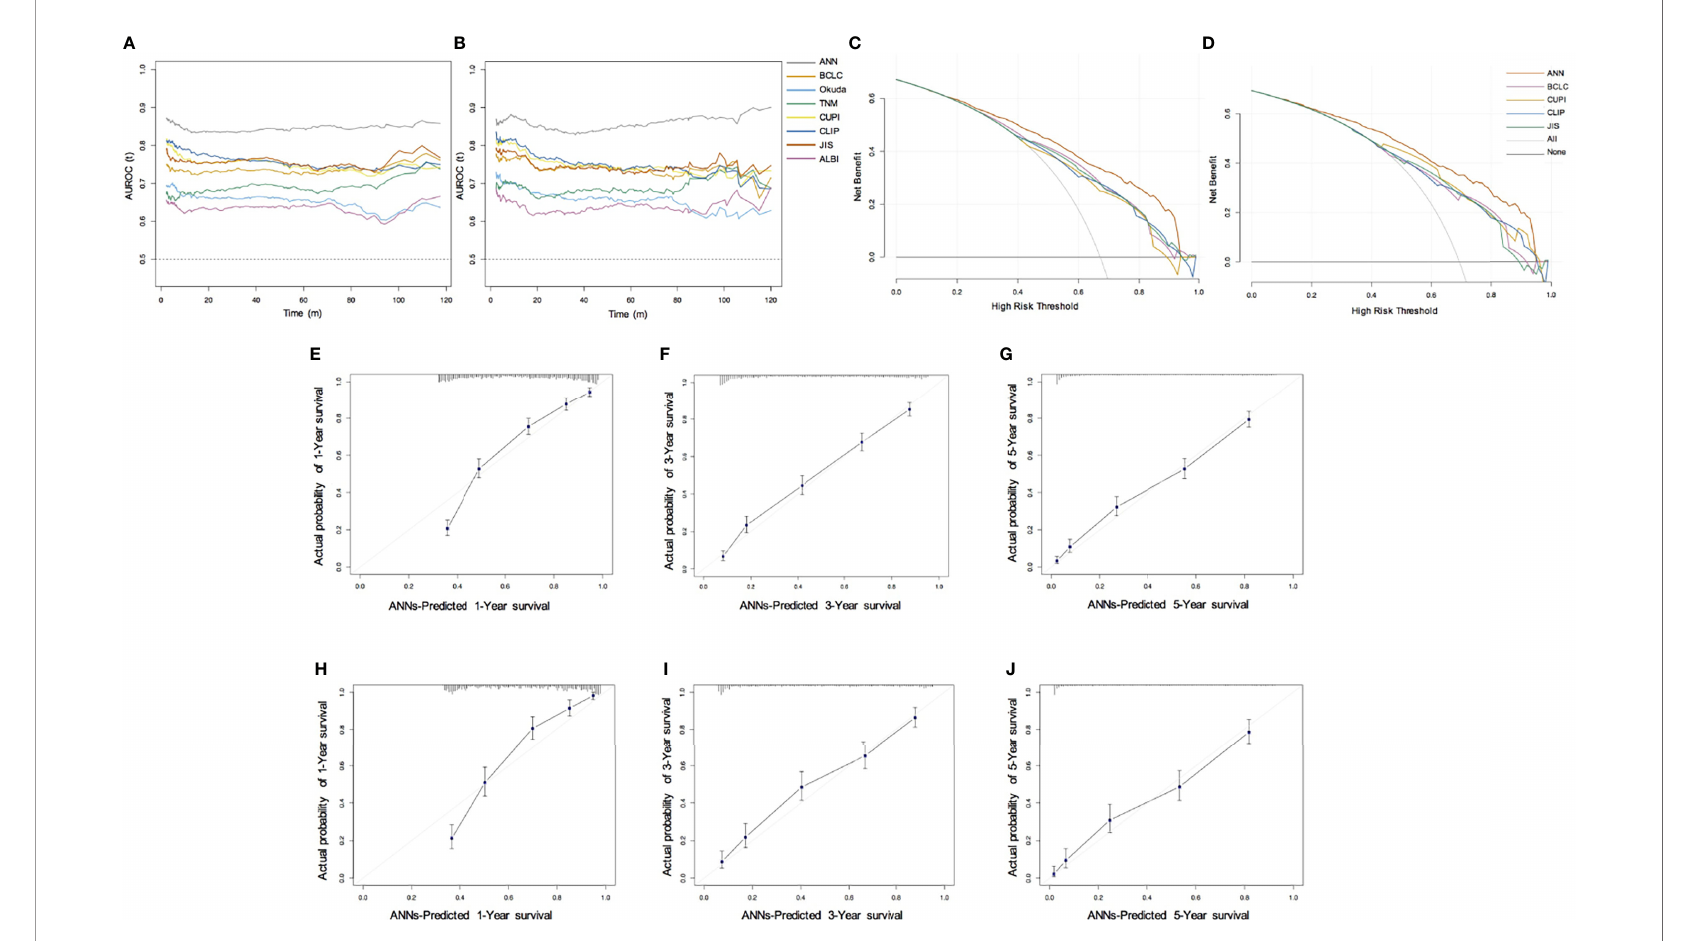
FIGURE 3 | Performance of ANN model. (A, B) Time-dependent area under the ROC curve for the long-term risk prediction of HCC patients in the training (A) and validation cohort (B) ; (C, D) Decision curve analysis for predicting the OS in the training (C) and validation cohort (D) ; (E – G) Calibration curve for predicting 1-year, 3-year, and 5-year OS in the training cohort; (H – J) Calibration curve for predicting 1-year, 3-year, and 5-year OS in the validation